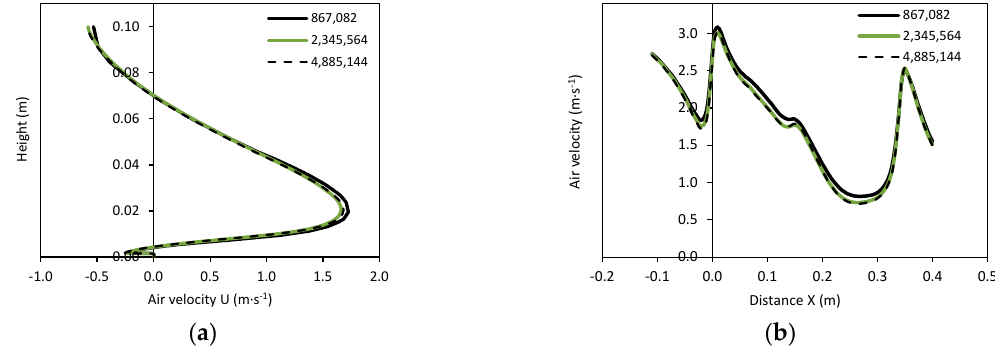
Figure 7. A grid independency study with three density grids. ( a ) vertical profile, and ( b ) horizontal profile inside middle of the NVD barn with SM opening conditions.